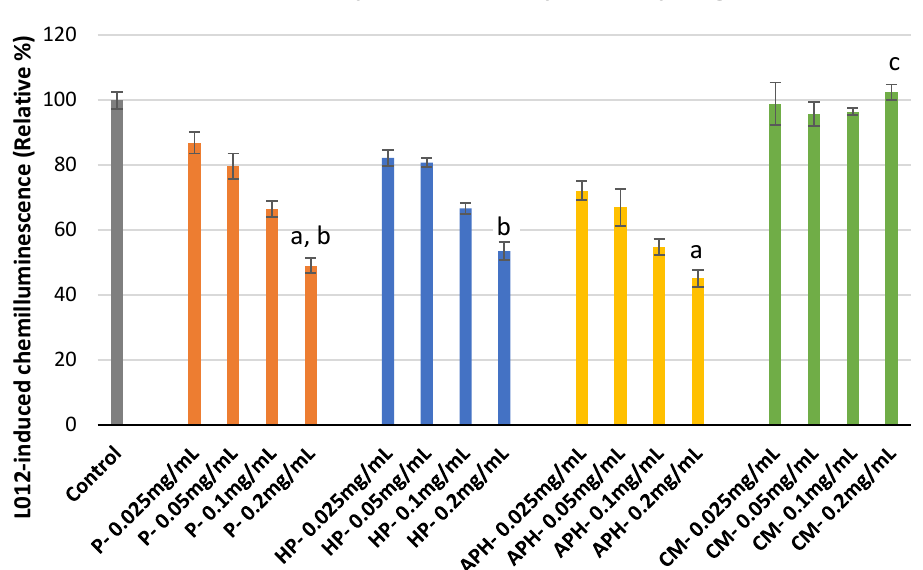
Figure 3. ROS production modulation in PMA (phorbol 12-myristate 13-acetate)-activated macrophages after exposure to P (water-soluble extract of pasteurized minced meat of BSFL), HP (water-soluble extract of hydrolyzed and pasteurized minced meat of BSFL), APH (hydrolysate of water-soluble BSFL proteins), and CM (water-soluble extract of chicken meal). Results expressed as mean ± standard deviation (n = 3). Differences in the letters above the bars (a, b, and c) represent significant differences ( p < 0.05) in prevention of ROS production (via macrophages) by different samples analyzed during this